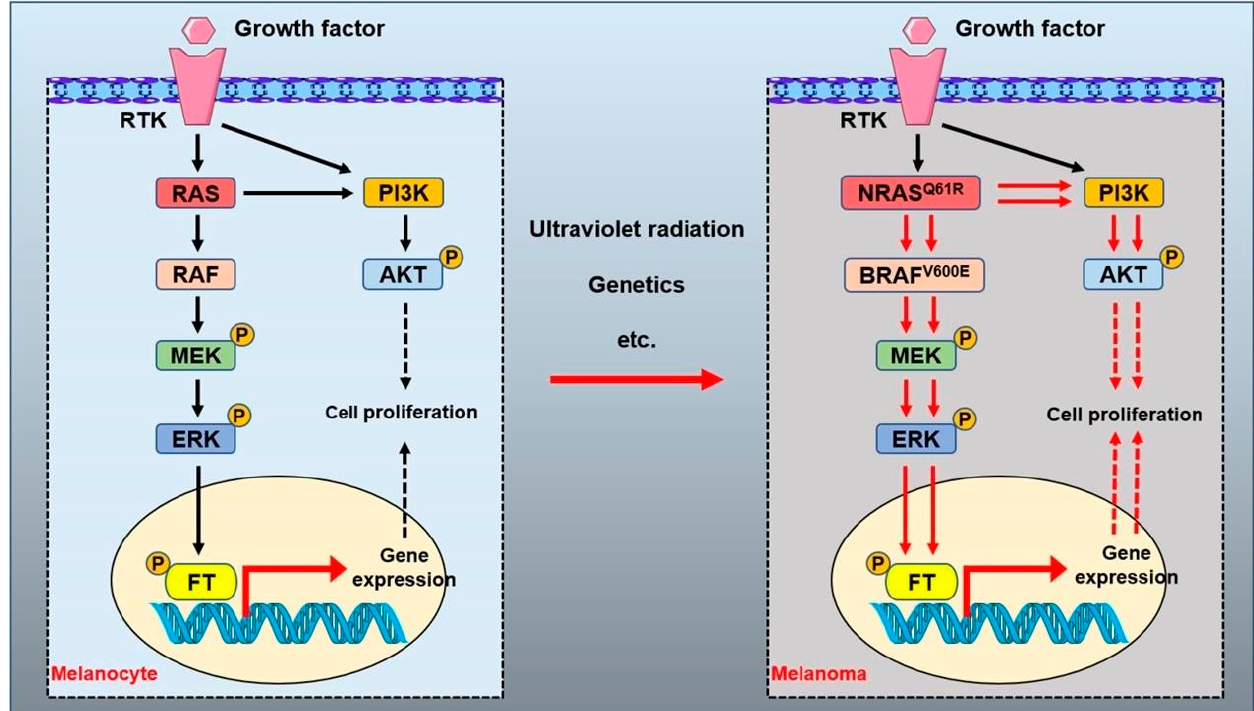
Figure 3. RAS signal pathways in melanoma. The mitogen-activated protein kinase (MAPK) and PI3K–AKT signaling pathways regulated by RAS permit the balanced control of basic cellular functions in melanocytes. Numerous factors are related to the transformation of normal melanocytes into melanoma, including genetics and ultraviolet radiation. The mutant NRAS or BRAF activates the MAPK and PI3K–AKT signal pathways to promote the occurrence and proliferation of malignant melanocytes in melanoma. RTK: receptor tyrosine kinase. ERK: extracellular signal-regulated kinase. MEK: mitogen-activated protein kinase. AKT: protein kinase B. PI3K: phosphoinositide-3 kinase. FT: transcription factor. P: phosphorylated.